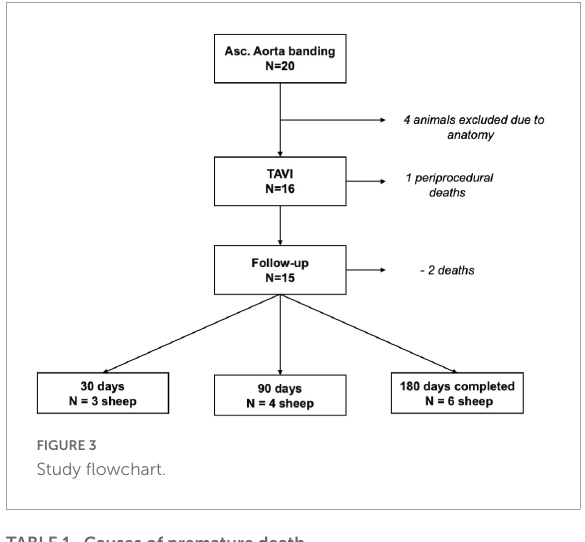
TABLE 1 Causes of premature death. Cause of death Number of